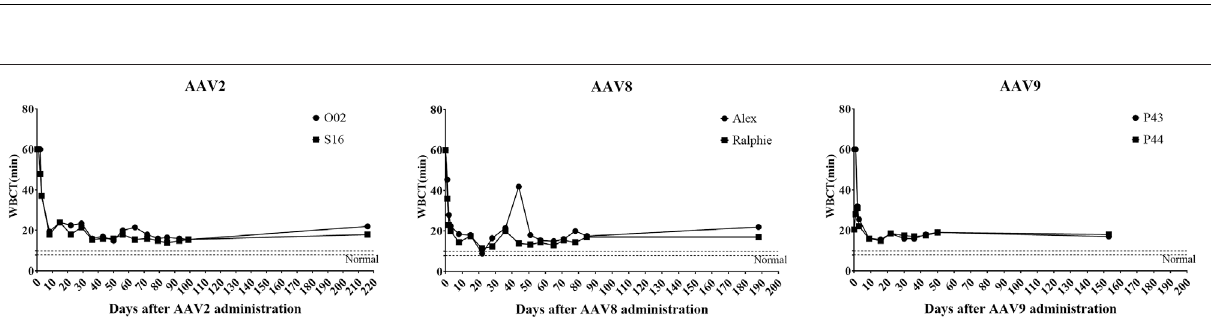
FIGURE 3 | Expression and activity of cFIX in hemophilia B mice after administration of AAV2, AAV8 or AAV9 vectors. Mice with FIX de fi ciency received 1 × 10 10 particles of AAV2, AAV8 or AAV9 with cFIX-opt-R338L transgene ( n = 5). Blood was collected from the retro-orbital venous plexus at weeks 1, 2 and 4. (A) canine FIX concentrations in plasmas were detected by ELISA. (B) cFIX activities were measured by aPTT assay.